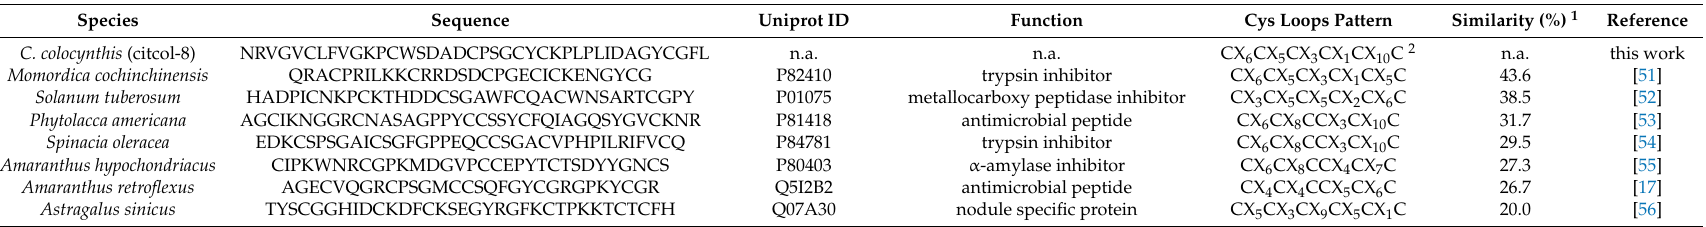
Table 3. Comparison of citcol-8 with representative plant cysteine-rich sequences and